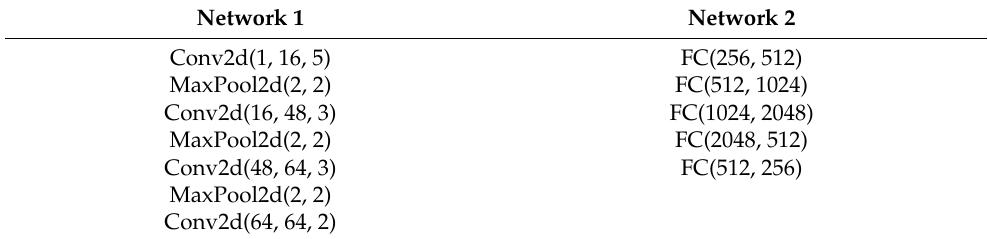
Table 3. Shared network